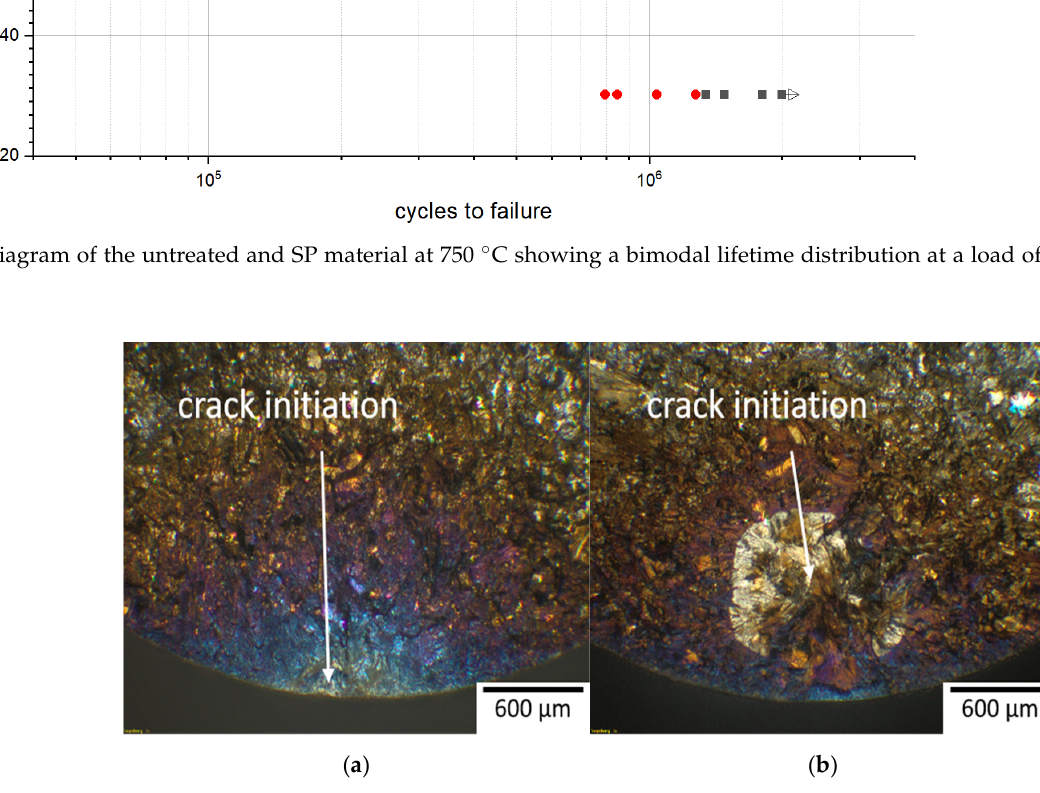
Figure 7. Fracture surface of samples tested at 260 MPa. ( a ) Fracture surface after ~300000 cycles with crack initiation from the surface starting at an impact and ( b ) fracture surface after ~500000 cycles with crack initiation from the volume.